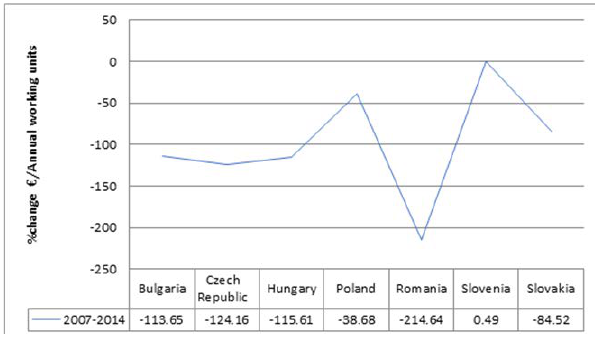
Fig. 2. Farmer standard of living as measured as a percentage change in income per family work unit (based in real terms on percent change in € per average work unit) in between 2007- 2014 in the nations of Central and Eastern Europe considered in the present study (Source: European Commission,